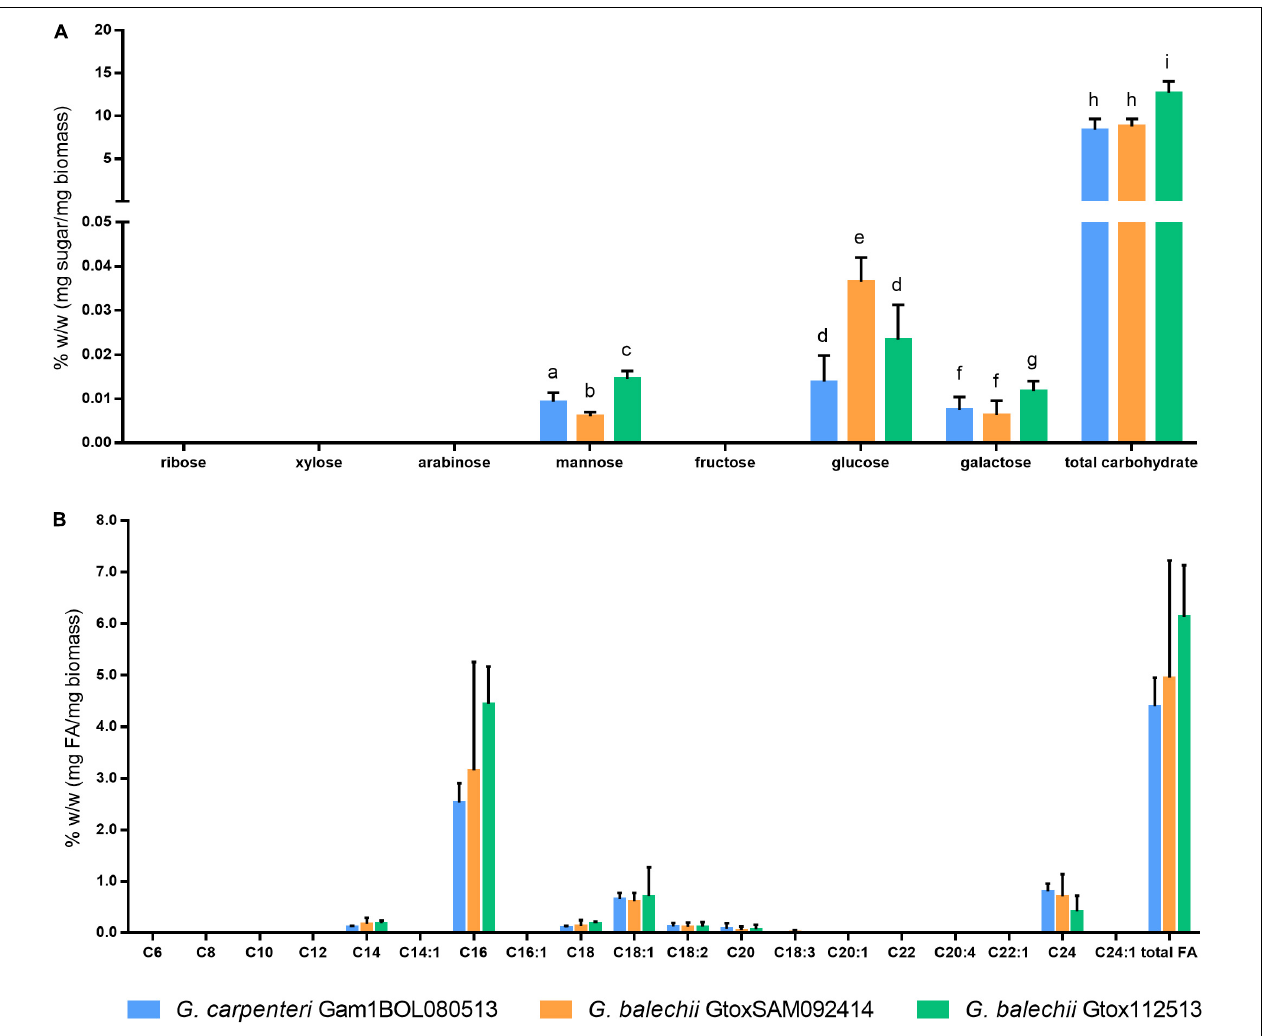
FIGURE 5 | Monosaccharide (A) and fatty acid (B) content of crude carbohydrate and lipid extracts of G. carpenteri Gam1BOL080513, G. balechii GtoxSAM092414, and G. balechii Gtox112513 biomass. The three strains showed significant difference in the monosaccharide content but not in the fatty acid composition. Results are presented as mean + SD from two biological replicates with three technical replicates each. Different letters indicate significant differences after one-way ANOVA analysis ( P <